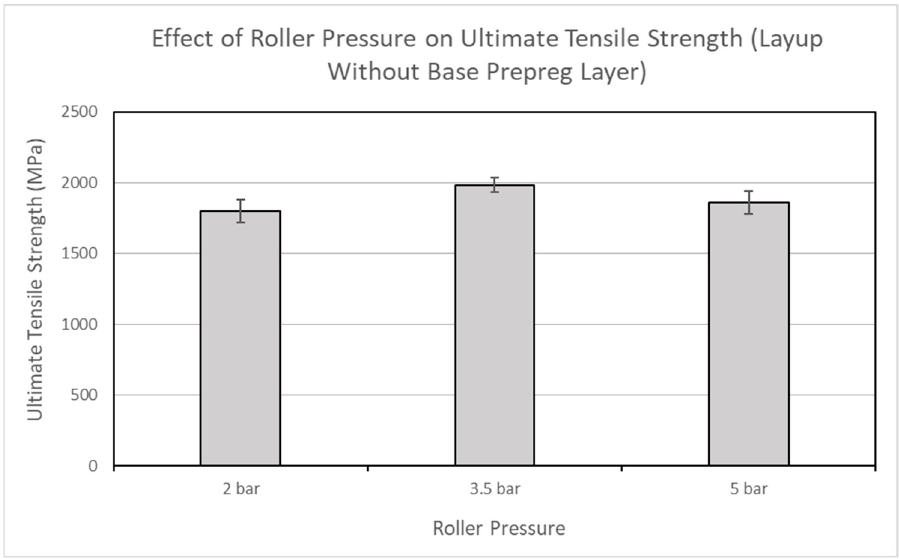
Figure 13. Effect of roller pressure and base layer on ultimate tensile strength for layups without prepreg base layer.